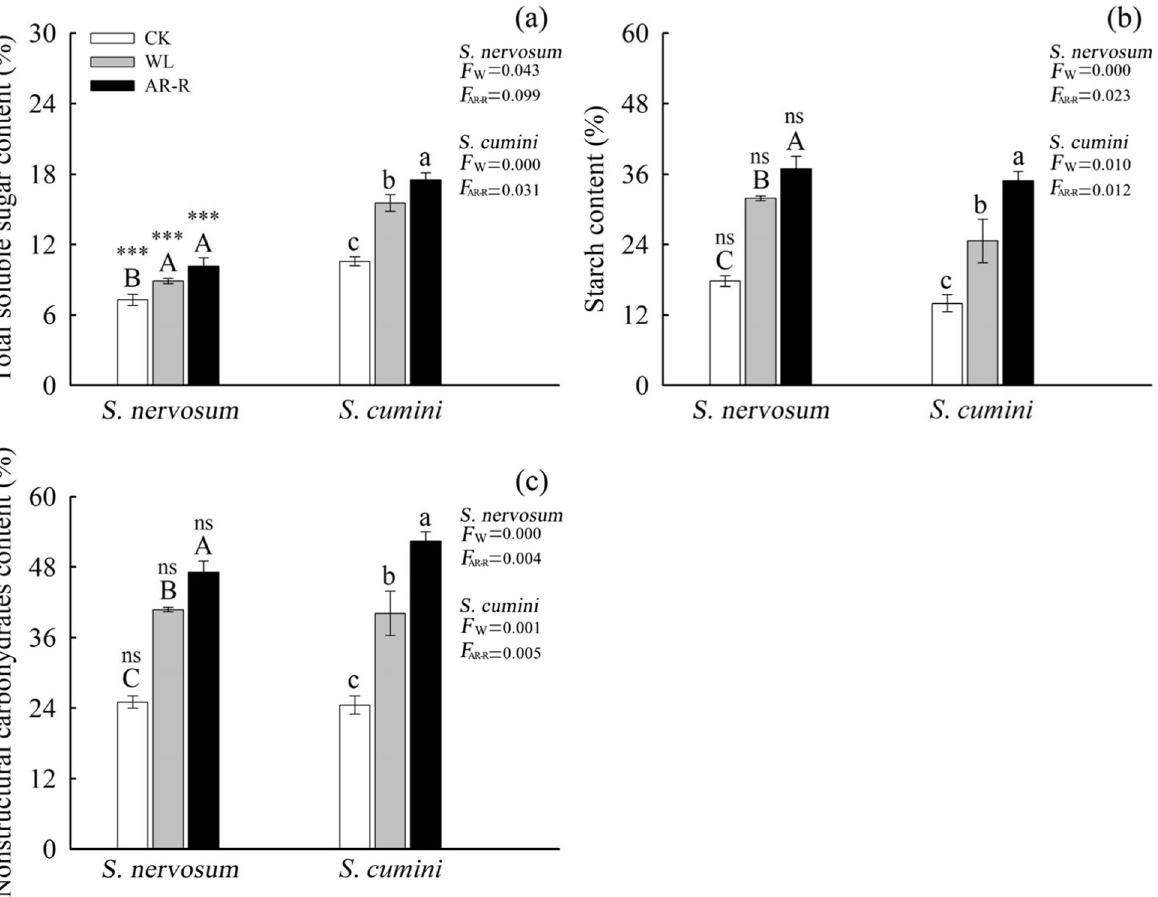
Fig. 5 Total soluble sugar ( a ), starch ( b ), and non-structural carbohydrates ( c ) contents of leaves in S . nervosum and S . cumini saplings, as affected by waterlogging with or without adventitious root removal. The abbreviations, explanation of treatments, and data description and statistics are the same as shown in